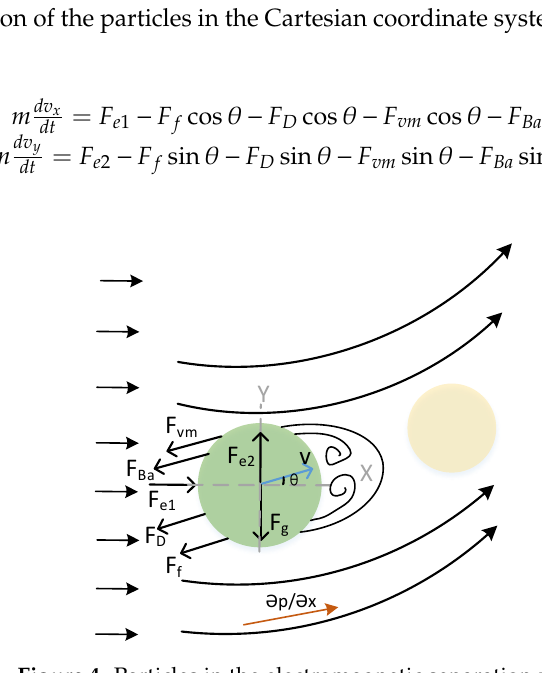
Figure 4. Particles in the electromagnetic separation zone.